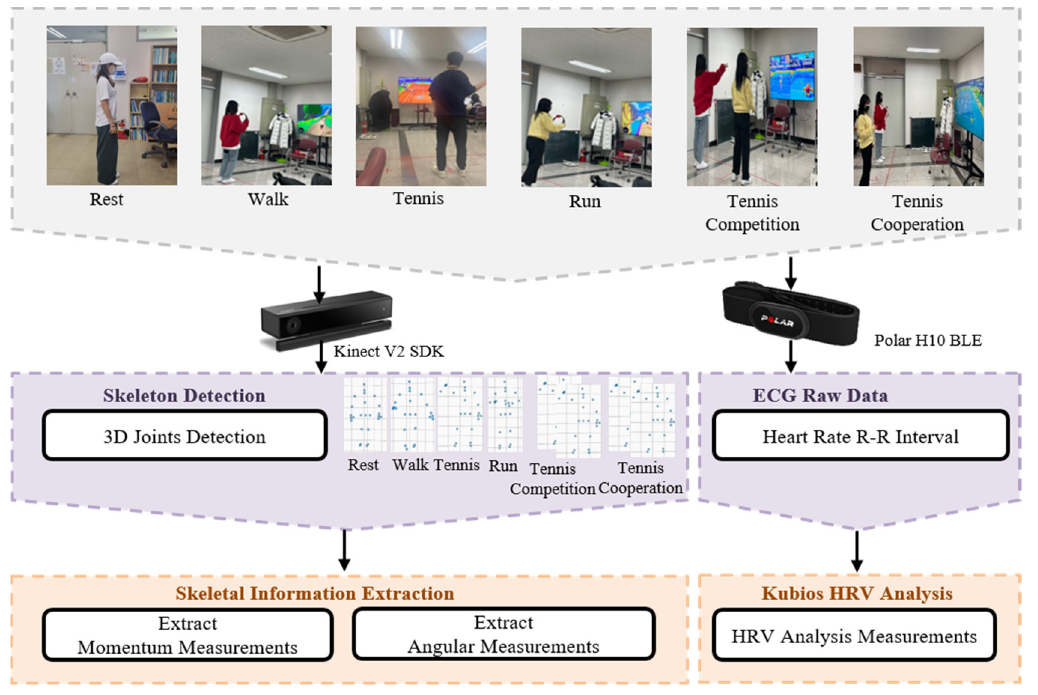
Figure 2. Subjects performing different types of exercise under different gameplay modes, measured by ECG and Kinect sensors.